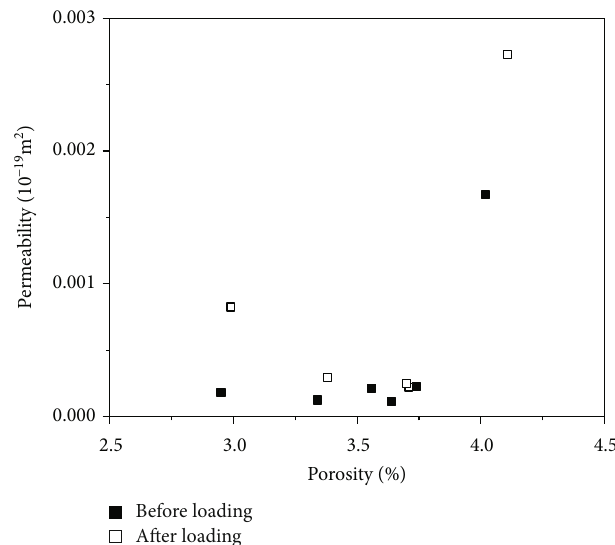
Figure 9: Relationship between permeability and porosity.